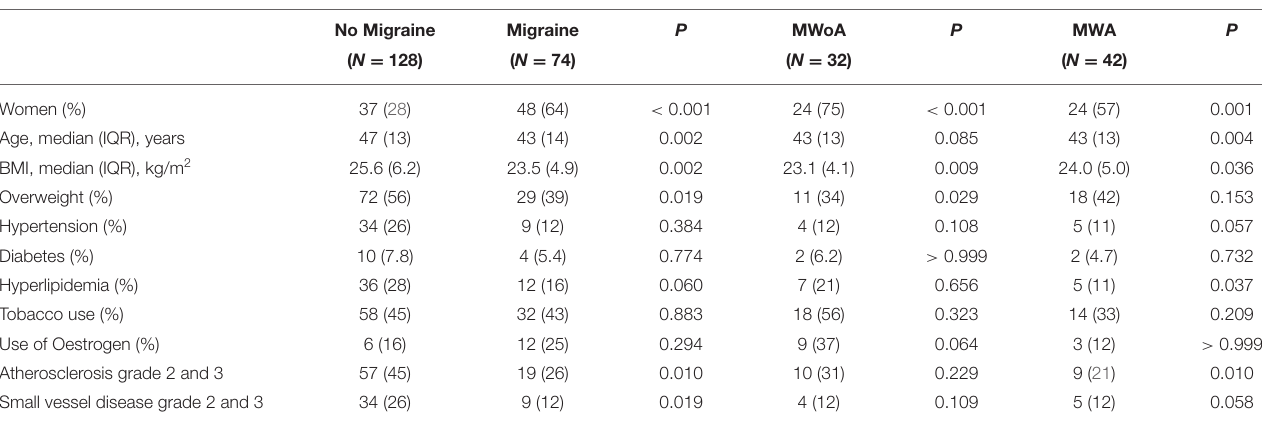
TABLE 1 | Characteristics of patients with cryptogenic